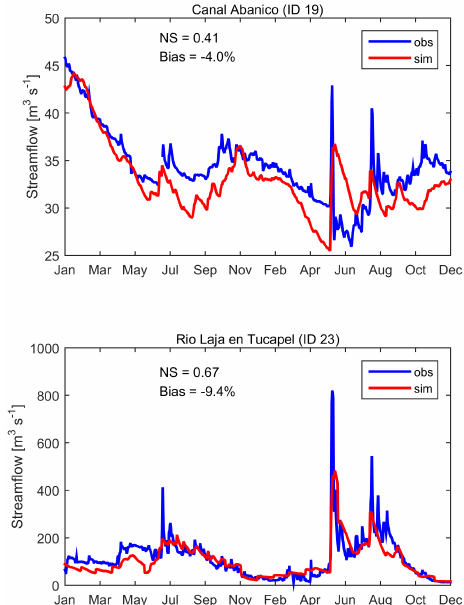
Figure 11. Daily observed vs. SPHY simulated streamflow (period 2007–2008) for the streamflow stations Canal Abanico (ID 19) and Rio Laja en Tucapel (ID 23). The Nash–Sutcliffe (NS) and bias model performance indicators are shown as